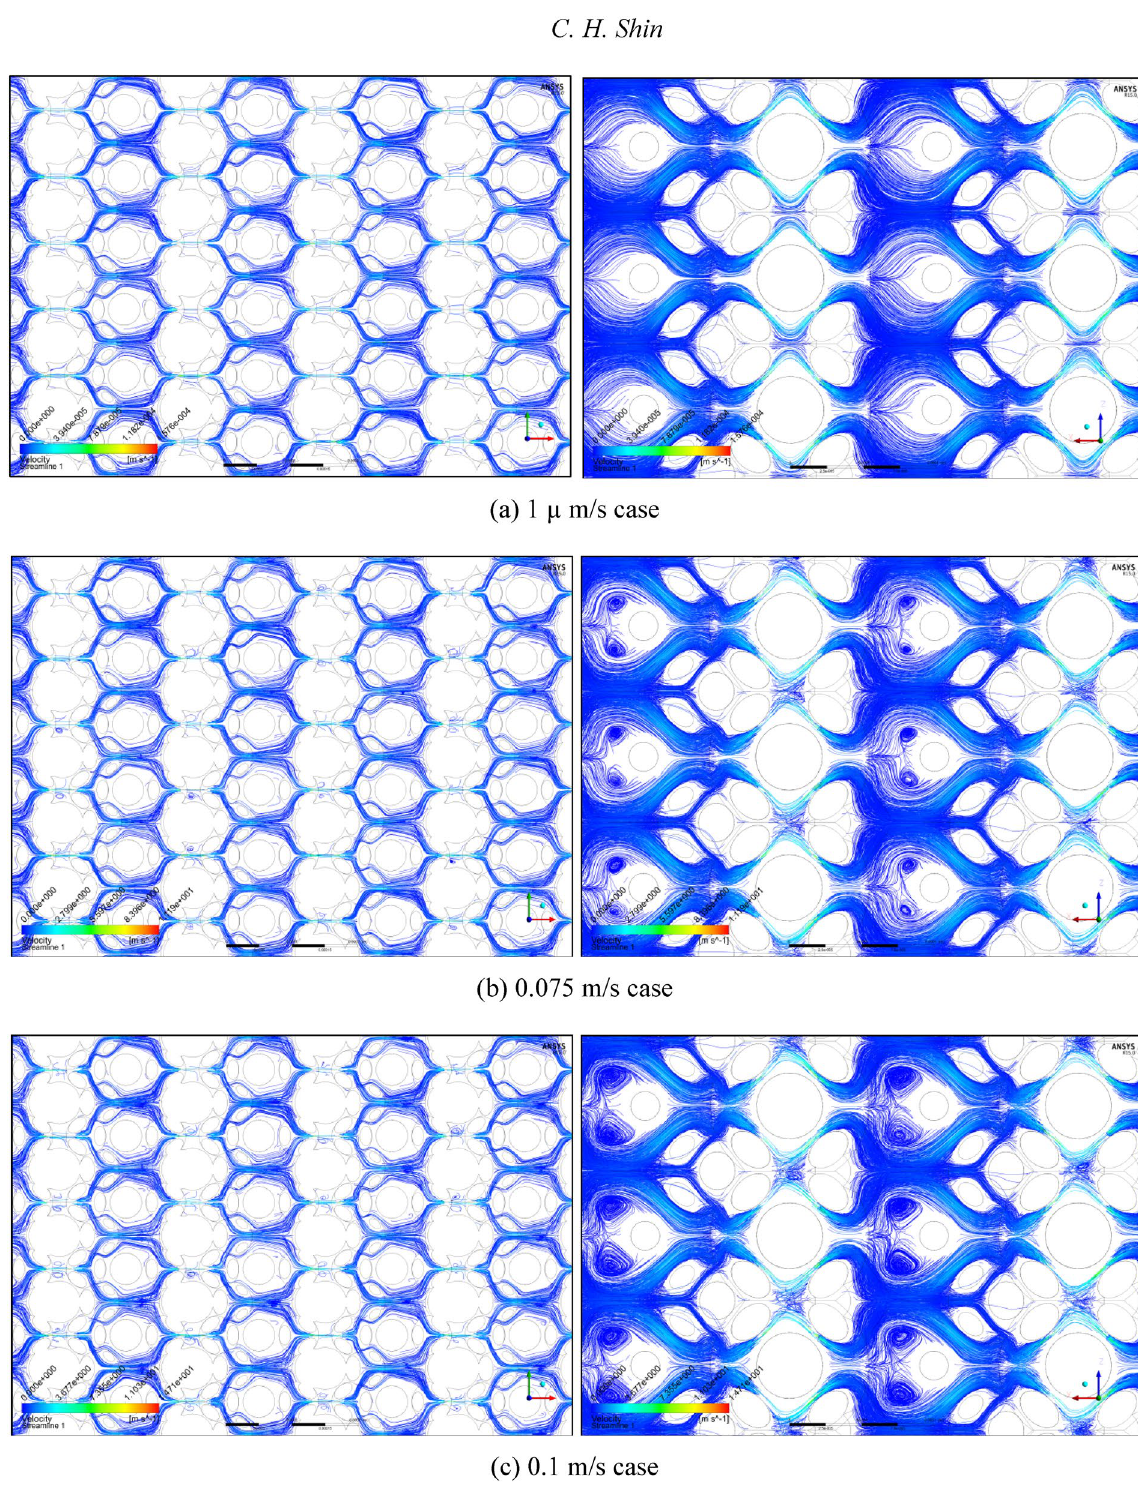
Figure 3. Streamline comparison of (C) multi-size base model in the three X-directional flow velocity conditions focusing on the centre parts in the X–Y (left) and X–Z (right)